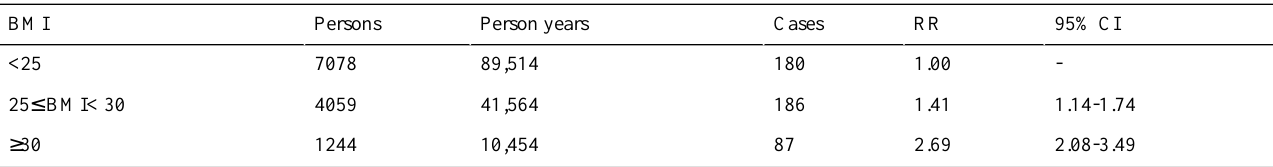
Table 3. Rate ratio (RR) with 95% confidence interval (CI) for hospital treatment or death due to IHD, 1991-2010, by body mass index (BMI) in a representative sample of Danish employees. a